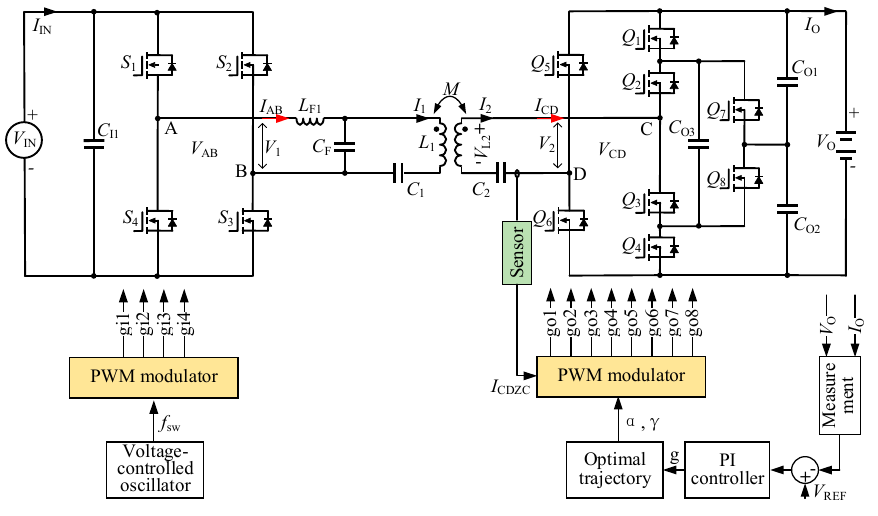
Figure 6. Block diagram of the control strategy.